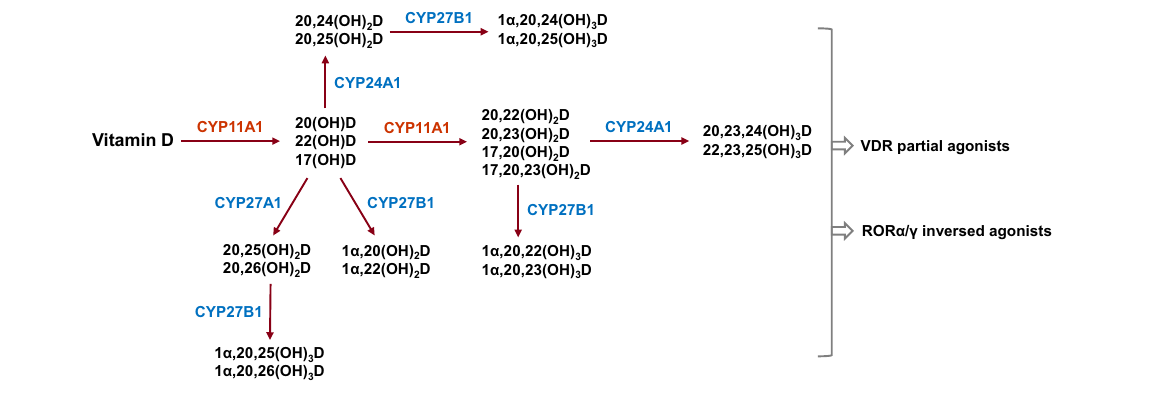
Fig. 2 The metabolites generated from alternative vitamin D metabolic